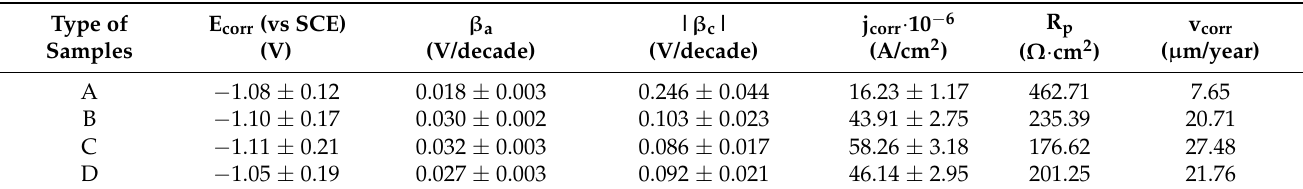
Figure 9. Tafel plots for hybrid coatings in 0.5M sodium chloride solution. Table 5. Tafel parameters of hybrid coatings determined from potentiodynamic polarization curves obtained in 0.5 M NaCl after 30 min of immersion.